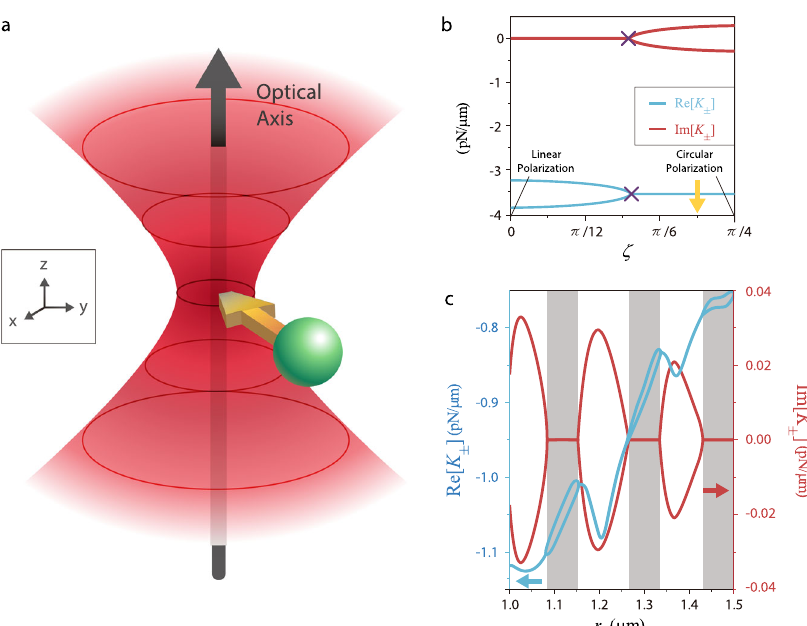
Fig. 1 Exceptional point in optical trapping of a single particle. a Schematic of the optical trapping of a dielectric particle ( n particle ¼ 1 : 57, r S = 0.5 μ m) by a strongly focused Gaussian beam ( λ ¼ 1 : 064 μ m, N.A. = 1.2, fi ling ratio = 1, power = 1 mW) in water ( n water ¼ 1 : 33). b K i versus the polarization ( ^ ε ¼ ^ x cos ζ þ i ^ y sin ζ ) of the Gaussian beam, ranging from linear ( ζ = 0) to circular ( ζ ¼ π = 4). The exceptional point of K by purple crosses), beyond which the eigenvalues become complex, which implies instability. c The stability also depends on the particle size. K i become recursively complex (white region) and real (gray region) as the particle radius is increased. The polarization used here is marked with a yellow arrow in b